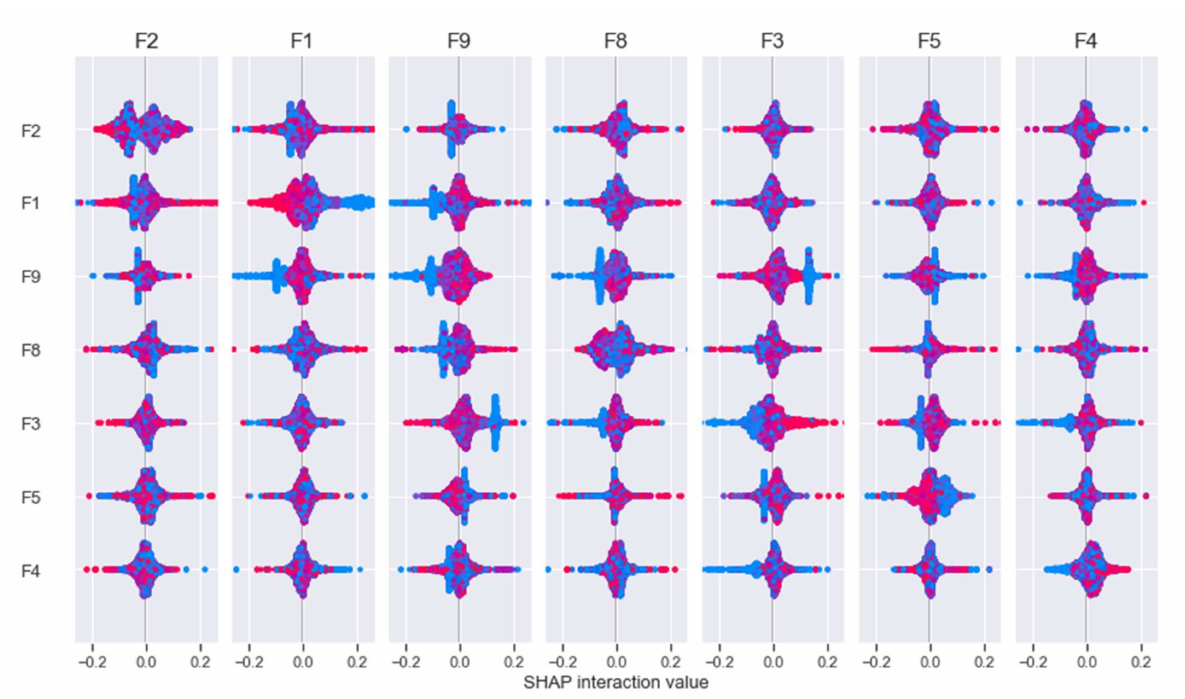
Figure 16. Interaction of features for the model